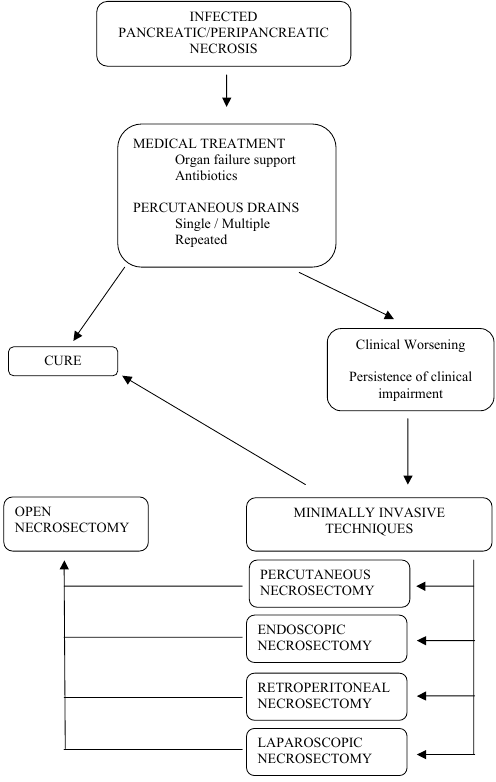
Figure 4. Algorithm for modern management of infected pancre- atic